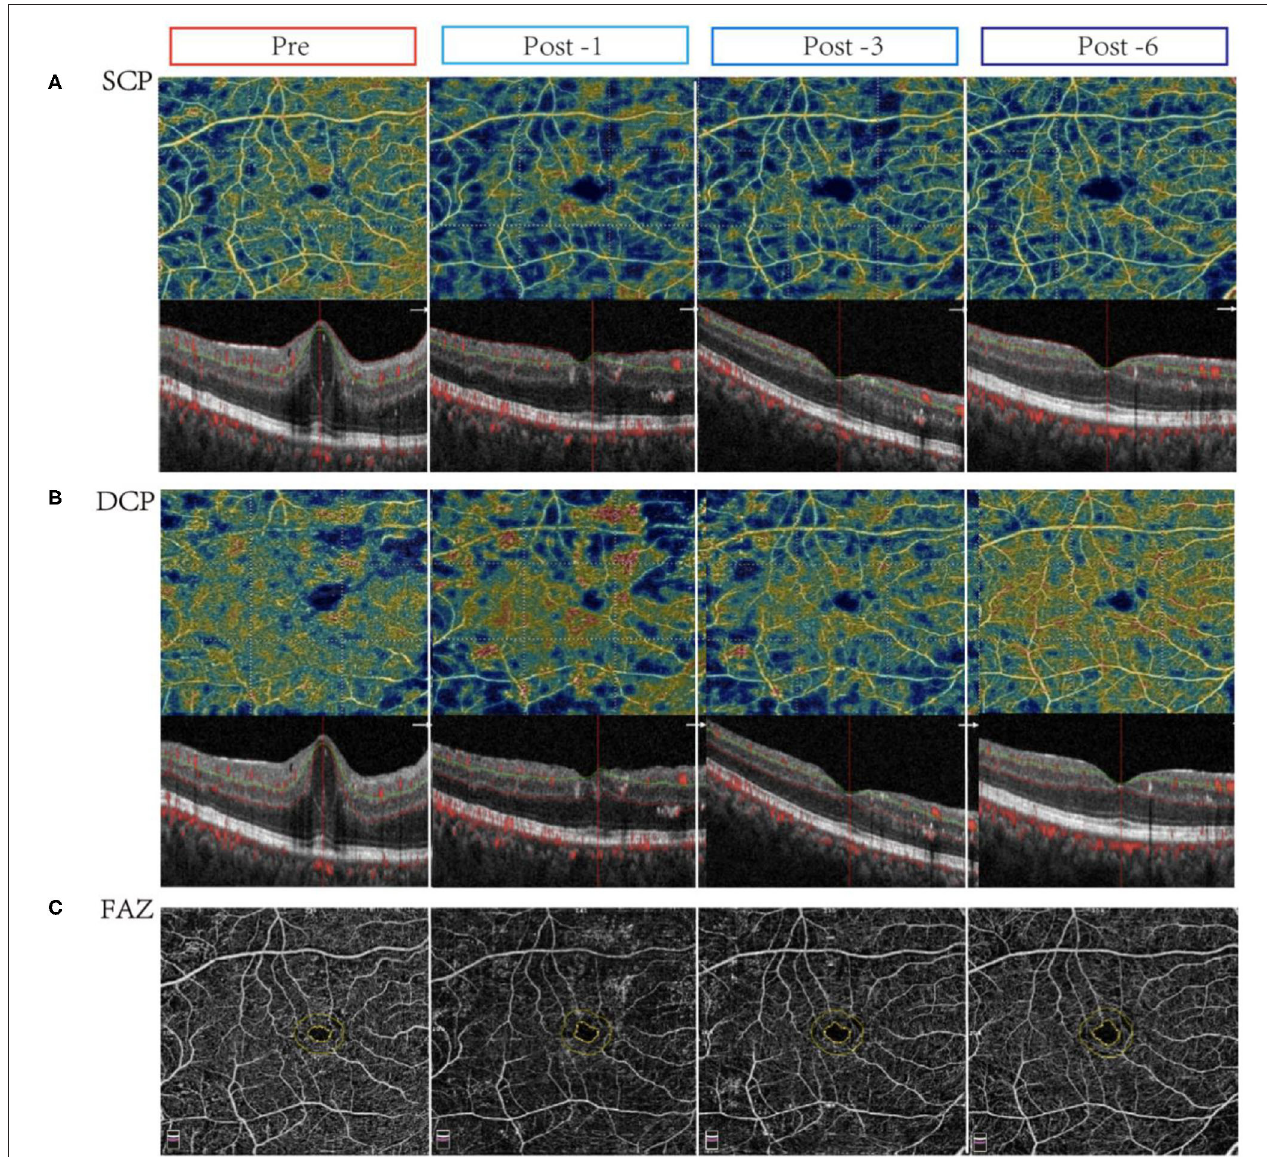
FIGURE 1 | Changes in vessel density and flow area in eyes with center-involved diabetic macular edema (CI-DME) before and after intravitreal conbercept injection. Pre: before treatment; Post -1: 1 month after treatment; Post -3: 3 months after treatment; Post -6: 6 months after treatment. (A) The vessel density in the superficial capillary plexus (SCP) in patients with CI-DME before and after treatment for 1, 3, and 6 months: after treatment, the microvascular density in the inferior area of SCP improved. (B) The vessel density in the deep capillary plexus (DCP) in patients with CI-DME before and after treatment for 1, 3, and 6 months: there were no significant changes in different areas of DCP before and after treatment. (C) The foveolar avascular zone (FAZ) in patients with CI-DME before and after conbercept intravitreal injection: there was no significant difference before and after treatment.